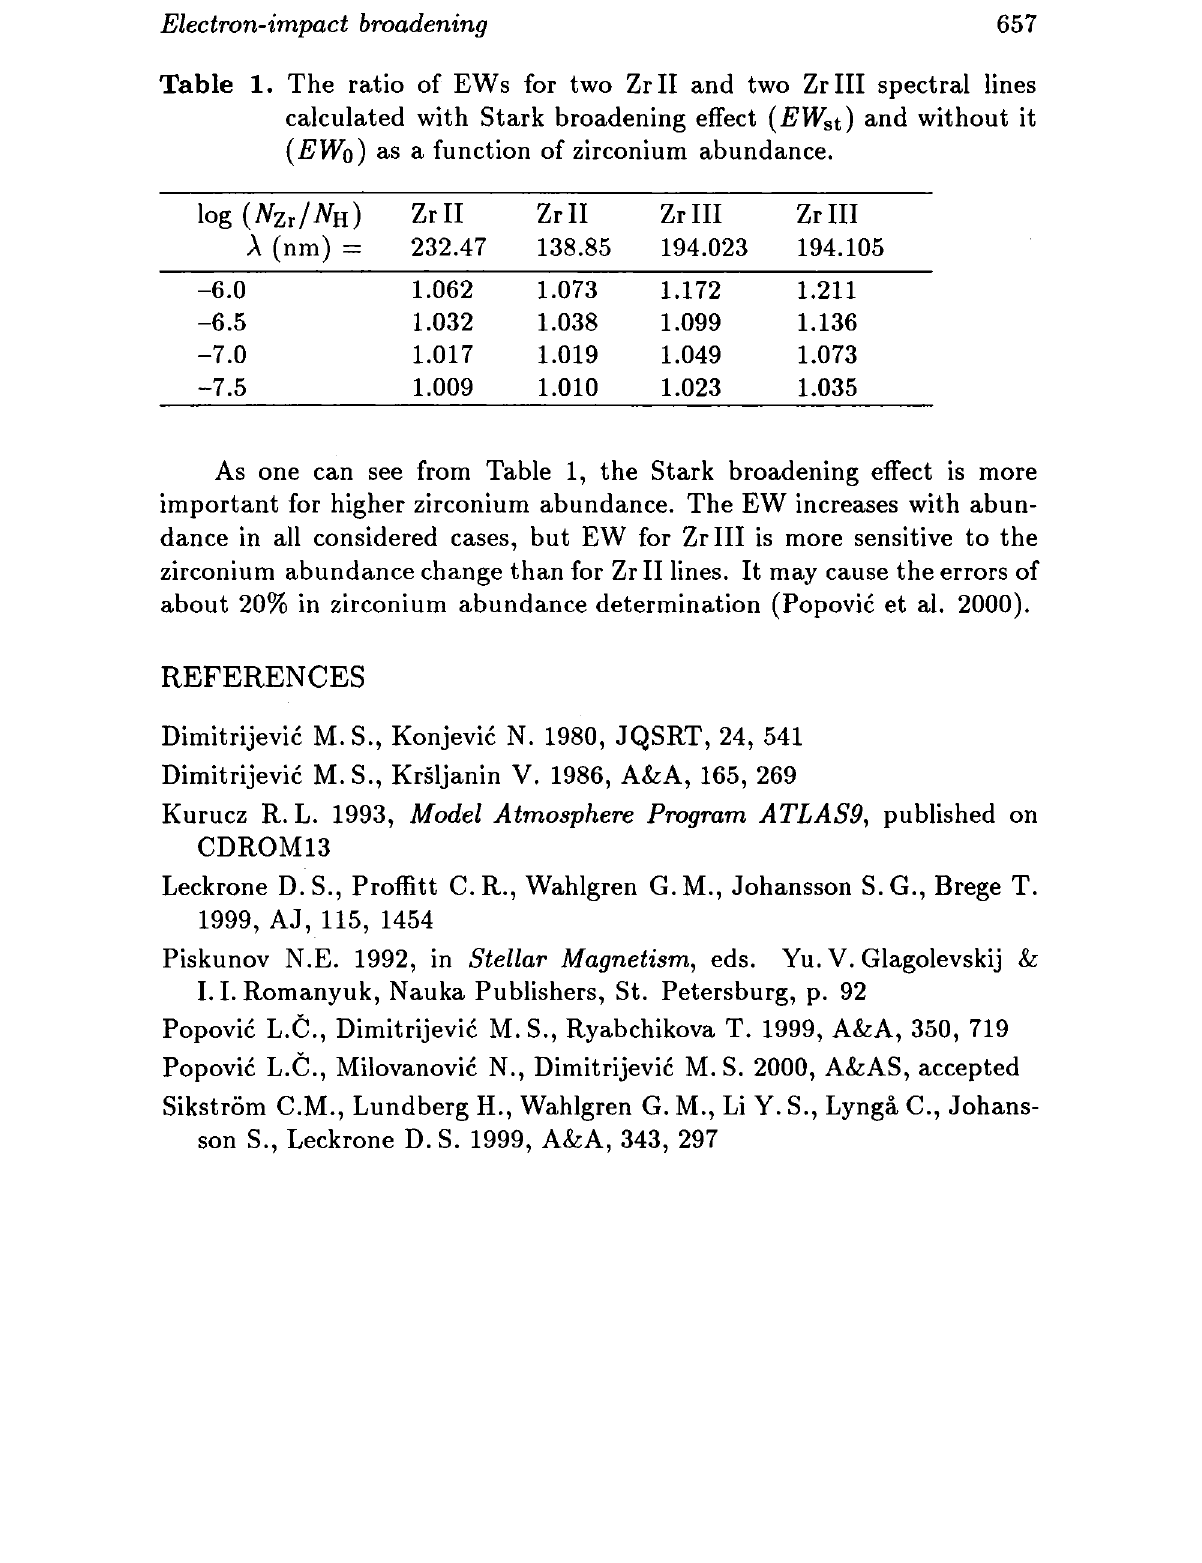
t) and without it s